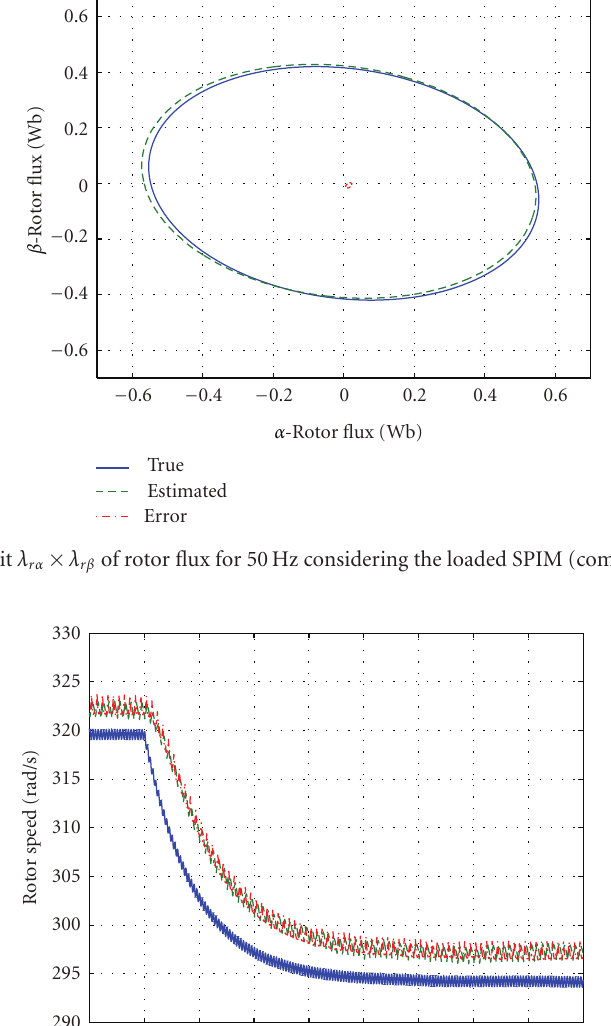
The design of close-loop α -flux observer is analogous to close-loop β -flux observer. The complete block diagram